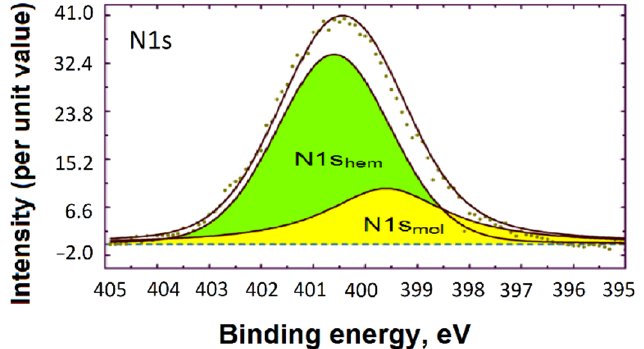
Figure 8. N1s spectrum of BTA adsorbed on steel surface after exposure in ID. After the decomposition of the N1s spectrum into components, two peaks with energies of 400.6 eV and 399.6 eV can be distinguished, which can be attributed to the inner layer chemisorbed onto the metal and the outer layer of the polymer coating, respectively. With an increase in the coating thickness, only a singlet peak with an energy of 399.6 eV remains on the N1s spectra.